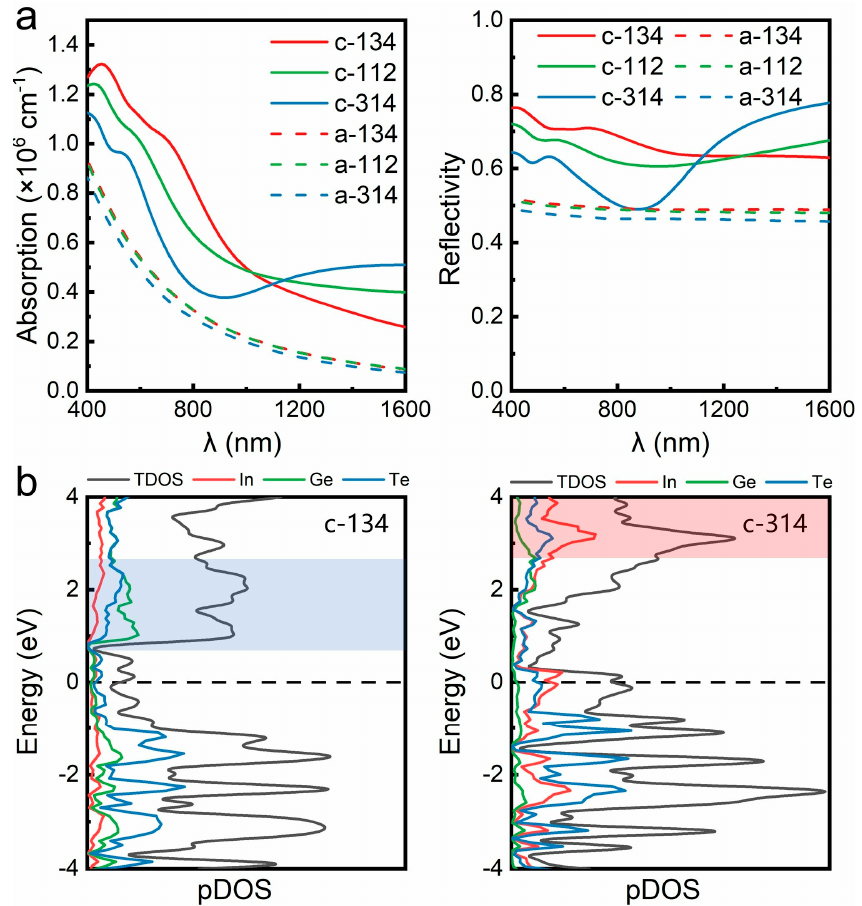
Figure 5. ( a ) Optical absorption and reflectivity of crystalline and amorphous phase of the three In-Ge-Te compositions. ( b ) Projected DOS (pDOS) of c-134 and c-314. Blue and red shaded areas highlight the peak regions of DOS above E F in c-134 and c-314, respectively.